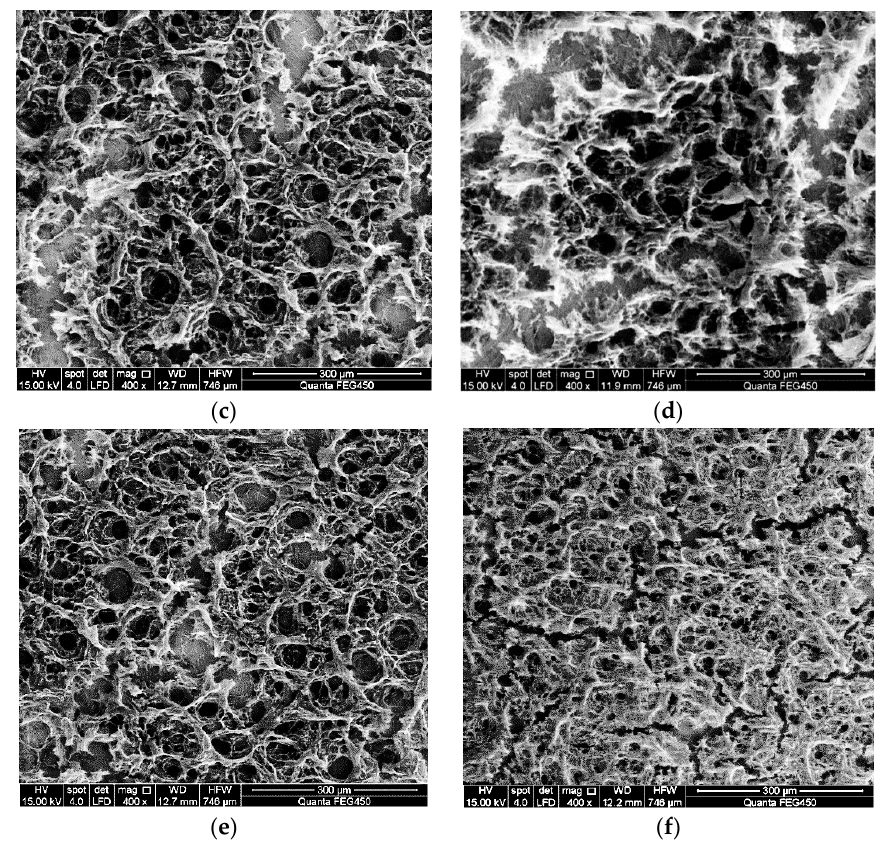
Figure 5. Molecular micromorphology of ASP solution after being acted on by the different medium tool: ( a ) 16 million (MD), 1000 mg/L; ( b ) 16 million (MD), 2000 mg/L; ( c ) 19 million (MD), 1000 mg/L; ( d ) 19 million (MD), 2000 mg/L; ( e ) 25 million (MD), 1000 mg/L; ( f ) 25 million (MD), 2000 mg/L.